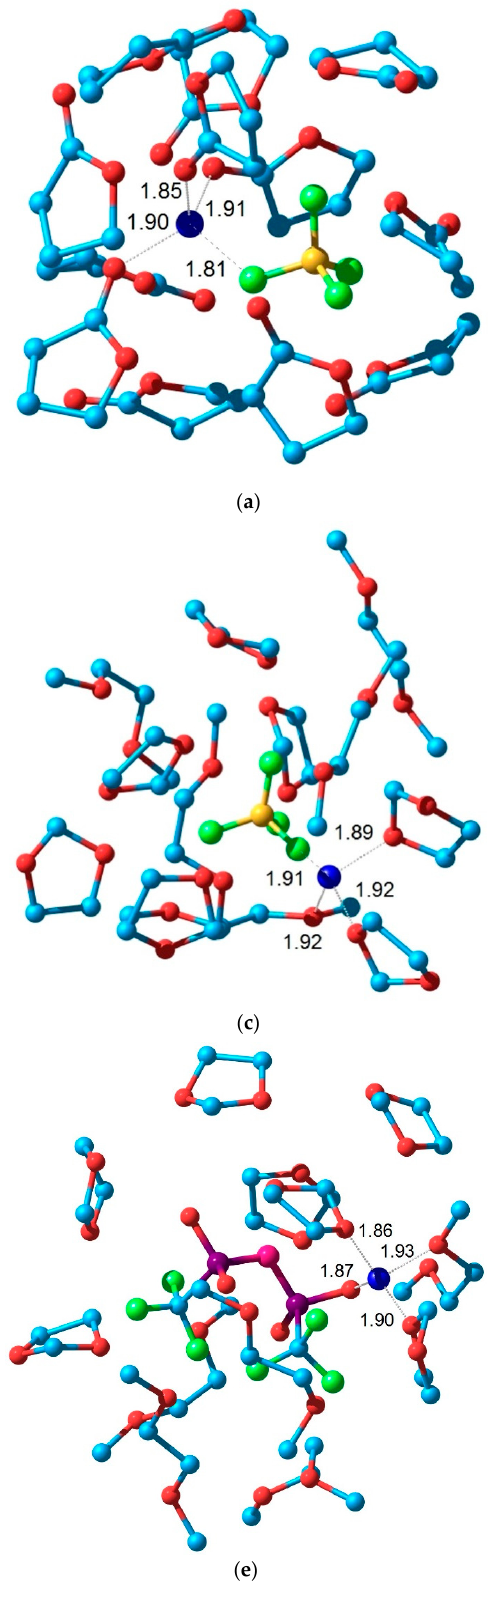
Figure 6. Structure of the model solvate complex including the ion pair ( a , c , e ) and separated ions ( b , d , f ) for the electrolytes: LiBF 4 in GBL ( a , b ); LiBF 4 in DOL/DME ( c , d ) and LiTFSI in DOL/DME ( e , f ). In the case of LiTFSI, the mobility of the cation and anion changes are comparable for compositions 3 and 4. At the same time, for LiBF 4 , the change to DOL/DME solution (com- position 2) leads to a significant increase (by a factor of 3–4) in both cationic and anionic mobility with respect to composition 1. This is not only the effect of significantly higher mobility of DOL and DME molecules, which is higher than the mobility of GBL molecules but is associated with the formation of more mobile ion pairs as well. The self-diffusion coefficients of solvents were determined individually (row 5 of Ta- ble 2) and in the DOL/DME mixture (row 6 of Table 2). DOL and DME molecules have the highest diffusion coefficients, and their mobility slightly decreases when a mixed solution of DOL/DME (1:1) is formed. In the electrolytes the mobility of DOL and DME molecules of solvents is reduced two or more times due to their involvement in the coordination sphere of less mobile ions and the effect is less pronounced for LiBF 4 solution (composition 2). In this case, the con- ductivity is the lowest due to the excess formation of neutral ion pairs of Li + BF 4– . Appar- ently, they have less strongly bound solvate shells, in contrast to ions. Accordingly, the proportion of free solvent molecules increases, which is accompanied by an increase in their diffusion coefficients (for DOL by 1.45 times, for DME by 1.78 times) in comparison with LiTFSI solution in DOL/DME with the highest conductivity. This is comparable to the increase in the mobility of 7 Li by a factor of 1.45 and that of 19 F by a factor of 1.75. The self-diffusion coefficients of DOL and DME in composition 2 are approximately equal to the average of their values in composition 3 and a pure DOL/DME mixture. This is consistent with the assumption about the formation of ion pairs and the release of pure solvent in the case of composition 2. There is some enhancement of GBL molecule mobility in composition 4 in compari- son with pure GBL solvent; this may be associated with more strong pair interactions of GBL molecules with high dipole moments. In this GBL/DOL/DME mixed solvent, one should expect a decrease in the proportion of GBL associates due to entropy effects in dilute GBL solution and a corresponding increase in the content of more mobile non-as- sociated GBL molecules.